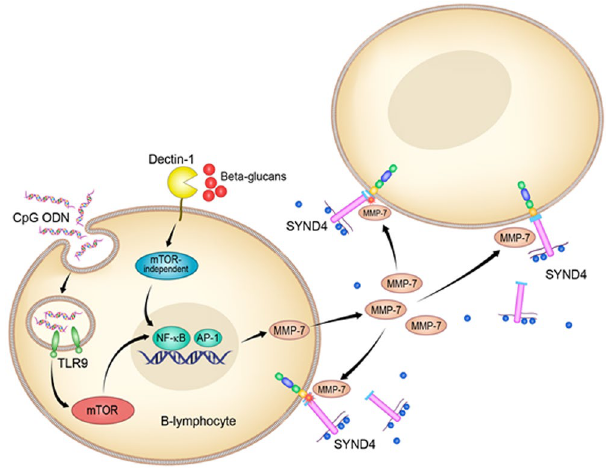
Figure 9. Proposed mechanism of MMP-7-mediated shedding of Syndecan-4 in activated B-lymphocytes. Circulating B-lymphocytes release MMP-7 after CpG and β -glucan stimulation through activation of TLR9 and Dectin-1 receptors, respectively. While CpG-stimulation is Rapamycin sensitive (mTOR-mediated), β -glucan is not (mTOR-independent) indicating different activation pathways. MMP-7 release participates in the shedding of